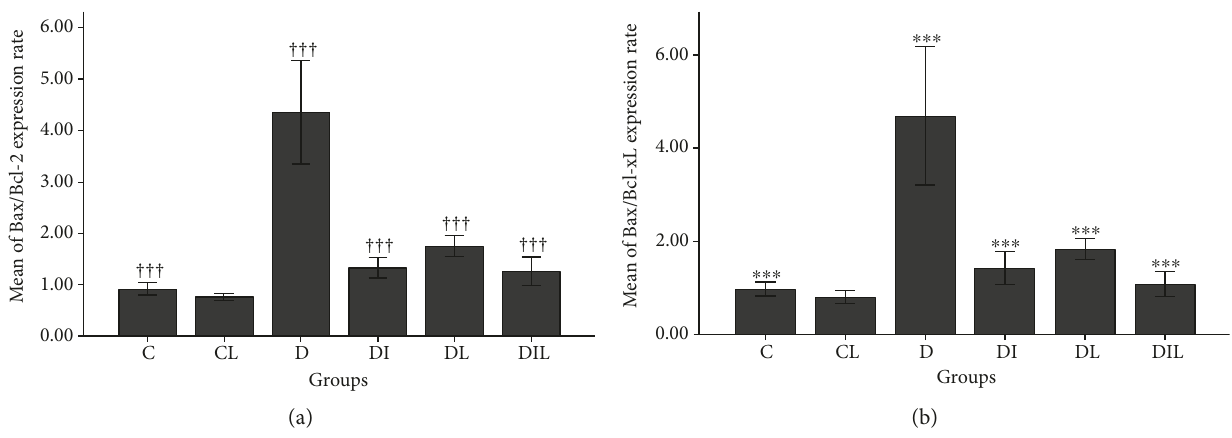
Figure 3: The e ff ects of insulin or honey or both on (a) Bax/Bcl-2 ratio at mRNA level in the hippocampus of the studied rats. ††† p < 0 001 , comparing (expression level of Bax gene) the untreated diabetic group (D) with the control group (C) and the diabetic group treated with insulin (DI), lycopene (DL), and both together (DIL). (b) Bax/Bcl-X ratio at mRNA level in the hippocampus of the studied rats. L ∗∗∗ p < 0 001 , comparing (expression level of Bax gene) the untreated diabetic group (D) with the control group (C) and the diabetic group treated insulin (DI), lycopene (DL), and both together (DIL). Bar graphs indicate the mean ± SEM ( N = 8